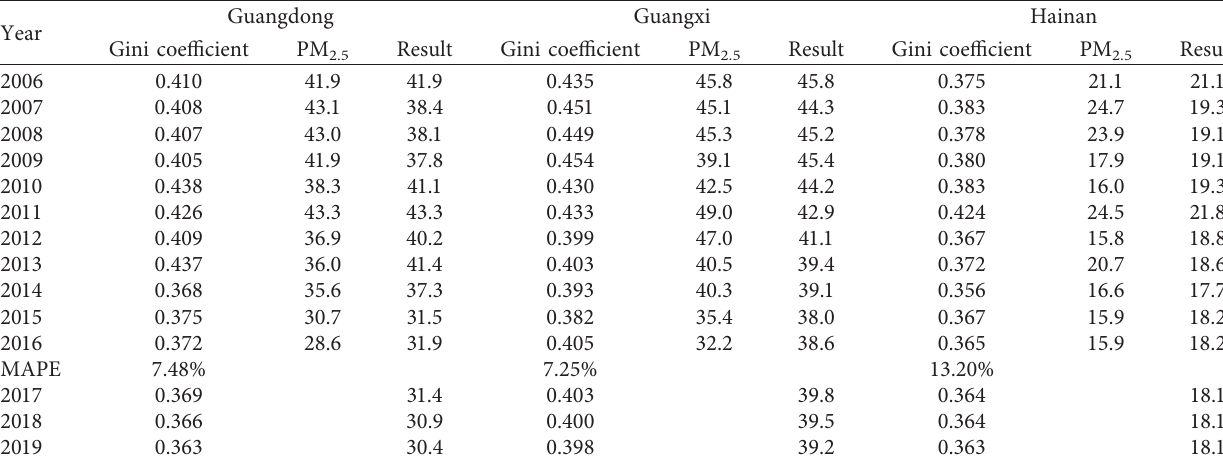
Table 7: Fitting results of the PM 2.5 concentrations in South